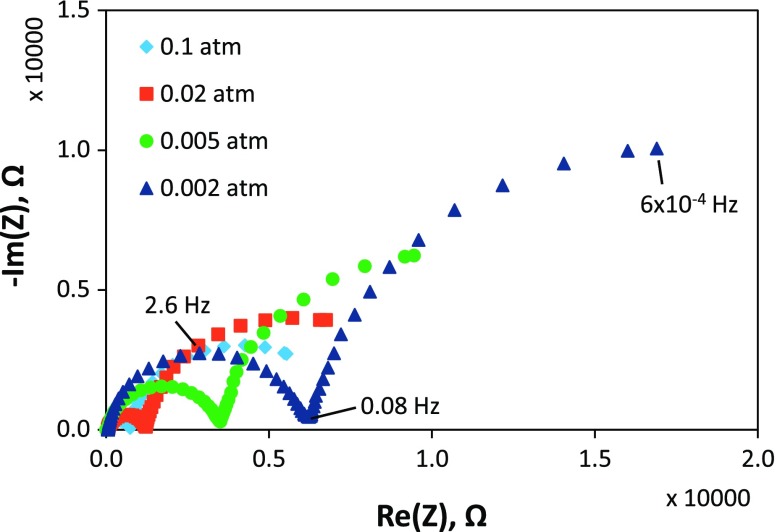
AC impedance spectra measured on the porous Pt/YSZ/STF/porous Pt cell at 600 °C in different oxygen partial pressures, as shown in the legend. Selected frequencies are indicated on some points for the spectrum measured in 0.002 atm O2.